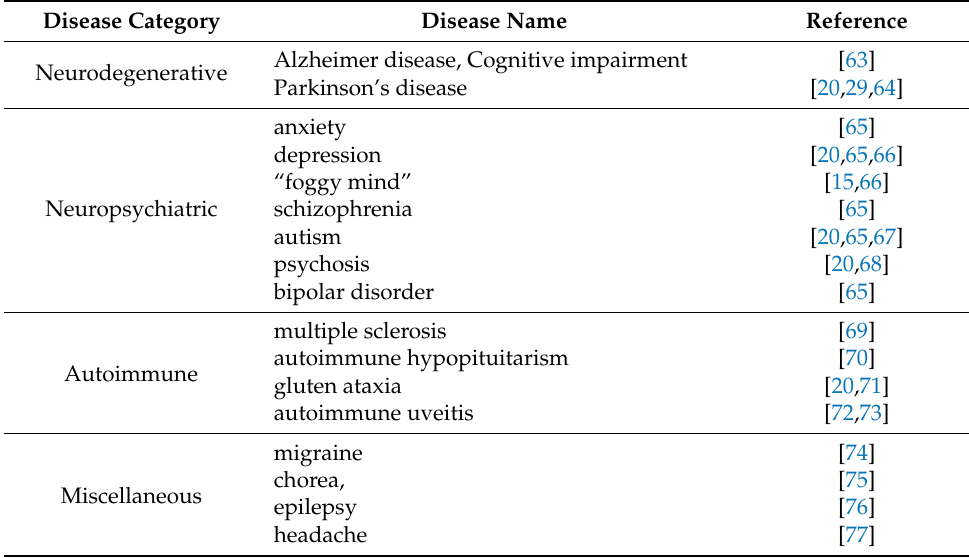
Table 2. Brain diseases that might benefit gluten